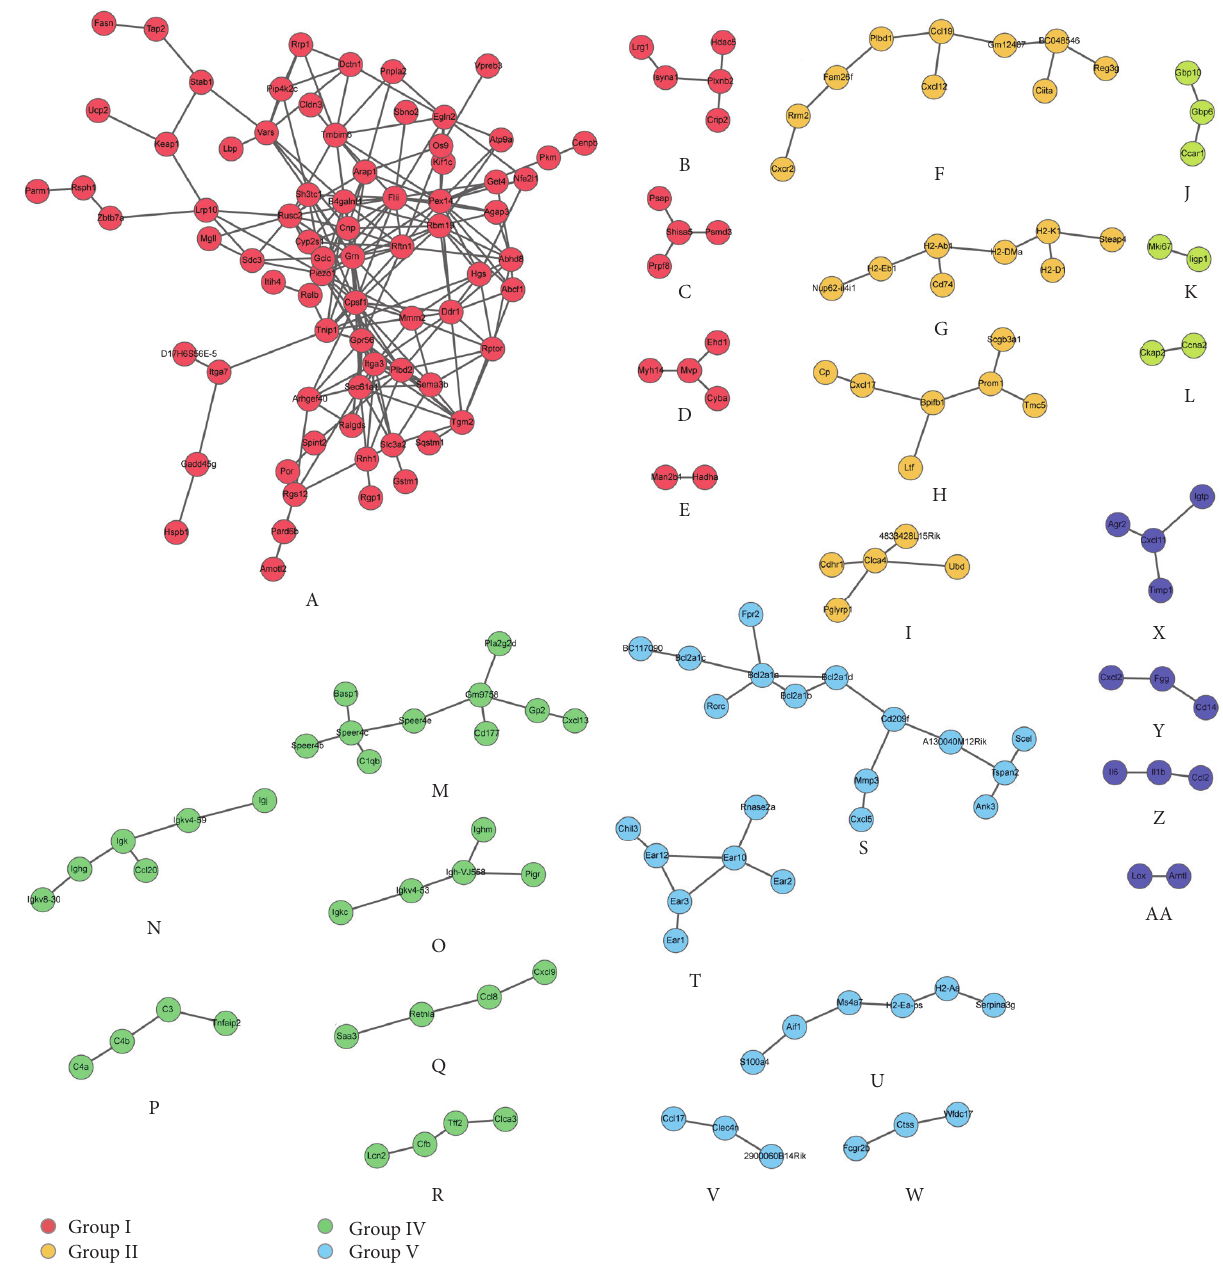
Figure 3: Network analysis. The 205 differentially regulated genes formed 27 clusters (A–AA). According to overlap in function, the clusters were subsequently combined in six groups